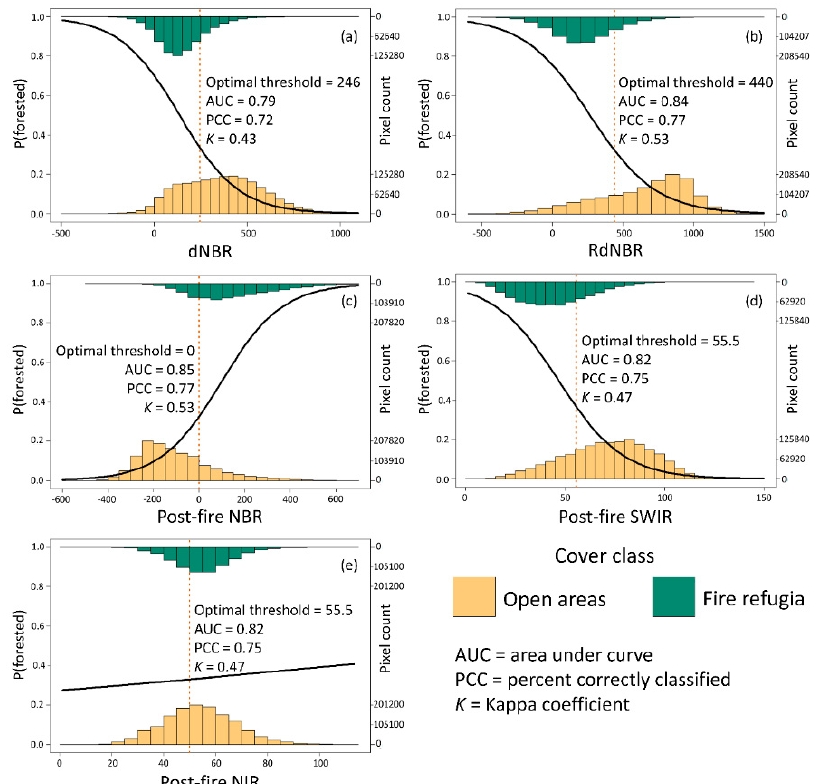
Figure 7. Distribution of spectral index values partitioned by cover class, logistic regression curves, optimal threshold values, and binary classification performance metrics for ( a ) post-fire NBR, ( b ) RdNBR, ( c ) post-fire shortwave near infrared (SWIR), ( d ) dNBR, and ( e ) and post-fire near infrared (NIR).